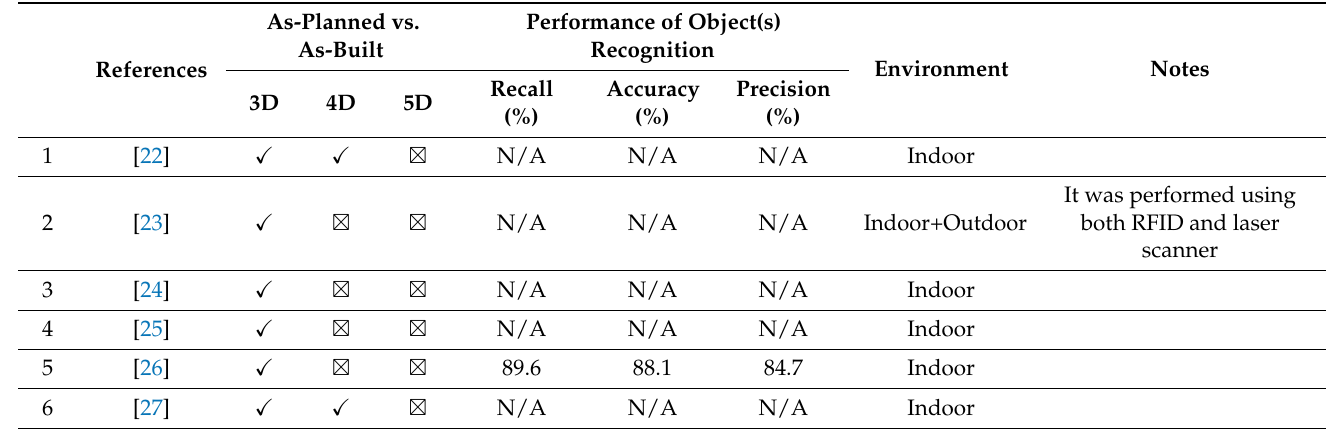
Table 2. Studies of RFID integrated with BIM in CPM: